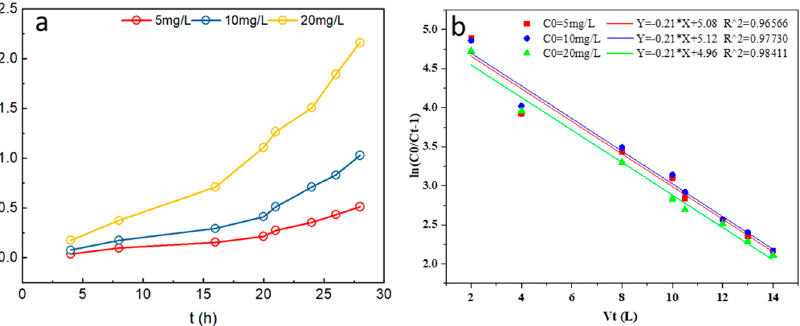
Figure 6. Column experiments with different initial P concentration. ( a ) Shift of P concentration in effluent; ( b ) fitting curves of Thomas model.